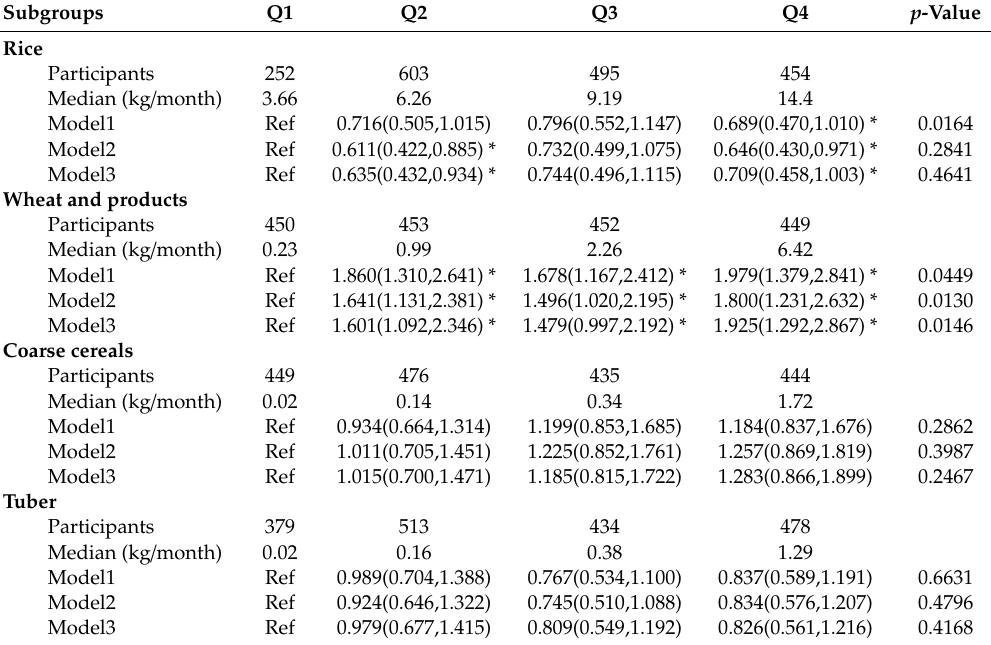
Table 4. The association between cereal subtype intakes and risk of metabolic syndrome among adults in the southern